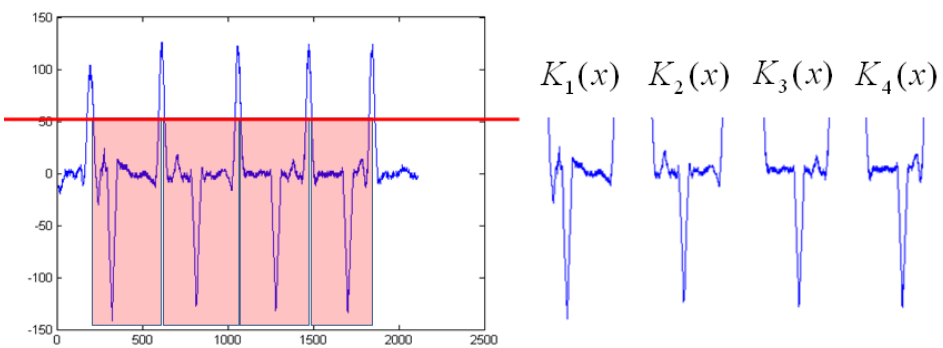
Figure 8. The feature extraction for K-curvature.